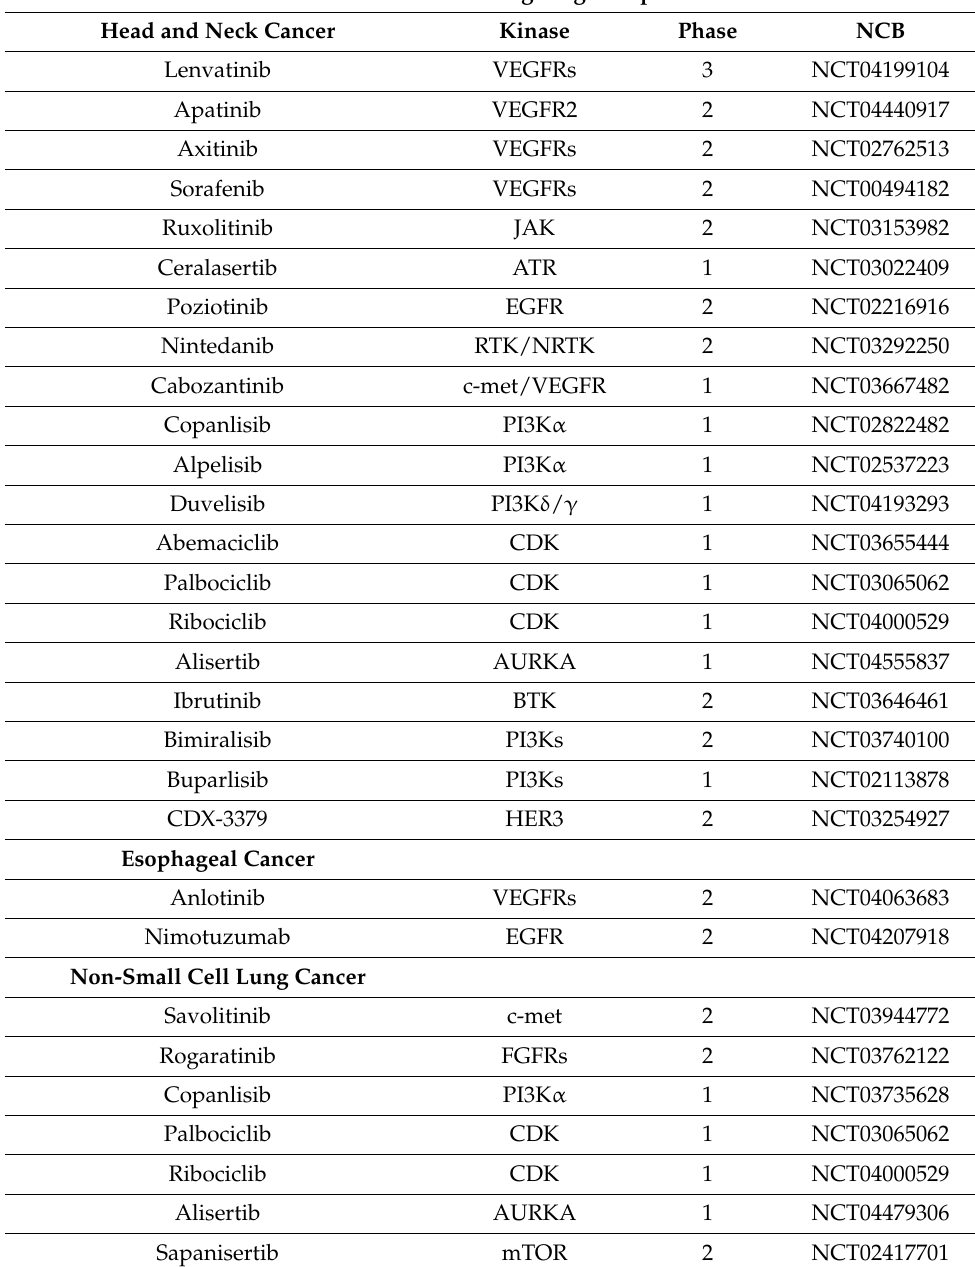
Table 2. Clinical trial compounds targeting kinases in